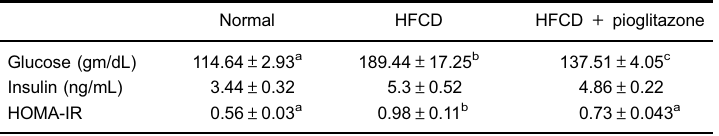
Table 2. Effect of high fat-carbohydrate diet (HFCD) and HFCD + pioglitazone on glucose, insulin, and homeostasis model assessment-insulin resistance (HOMA- IR)